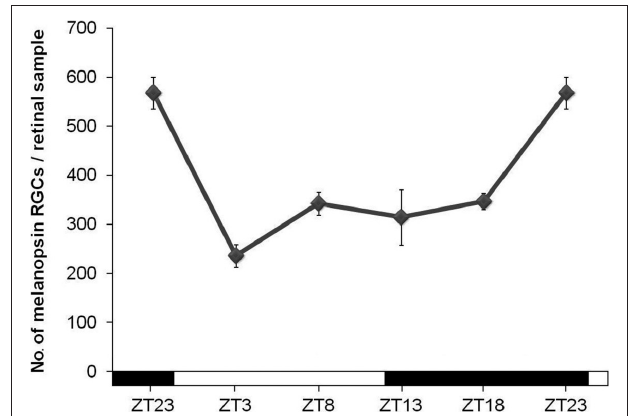
FIGURE 2 | Number of immunopositive cells throughout the 12 h L/12 h D cycle. The ANOVA test revealed a daily signifi cant oscillation ( p < 0.001). Post hoc tests detected a signifi cant decrease at the beginning of the light period ( p < 0.001) and an increase at the end of the night ( p < 0.05). ( n = 4 at each